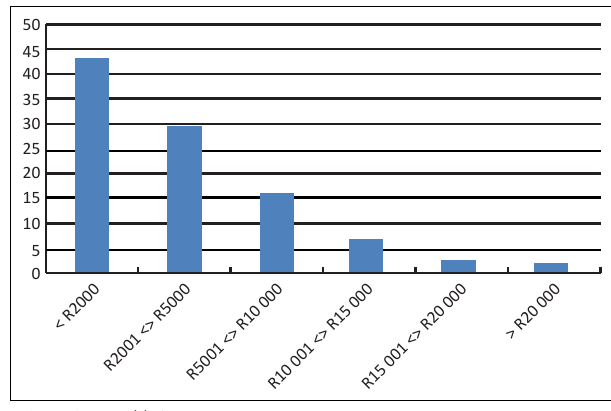
FIGURE 3: Monthly income.